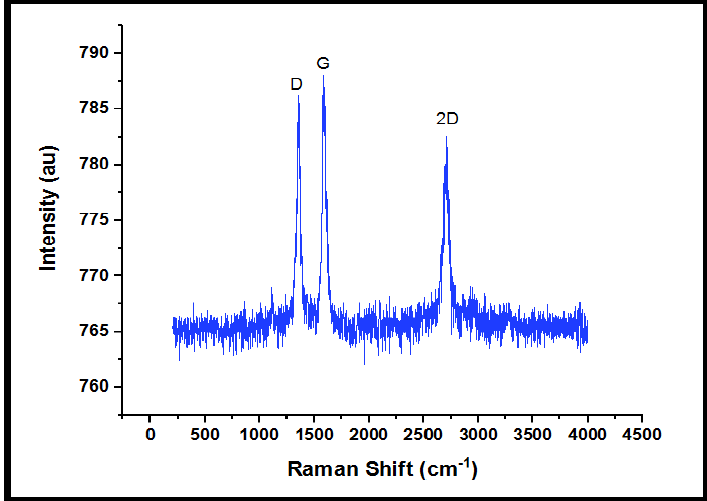
Fig. 2. Raman spectrum plot of